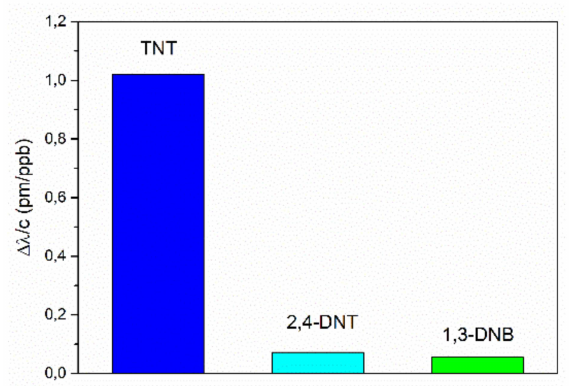
Figure 9. Shift of the resonant wavelength for 1 ppb concentration of explosive.